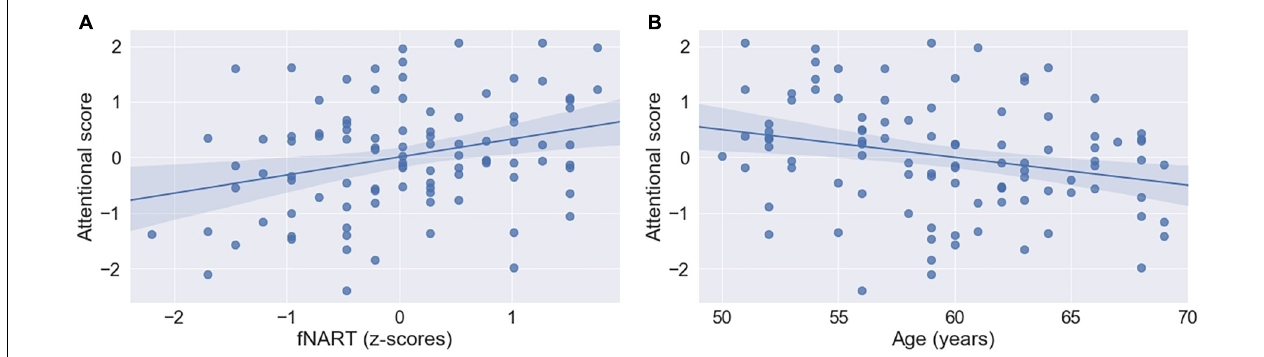
FIGURE 4 | Scatter plots visualizing association between attentional functioning, fNART (A) , and age (B) ( N = 101). Regressions were used for visual display only and not as a substitute for full GLMM statistics.